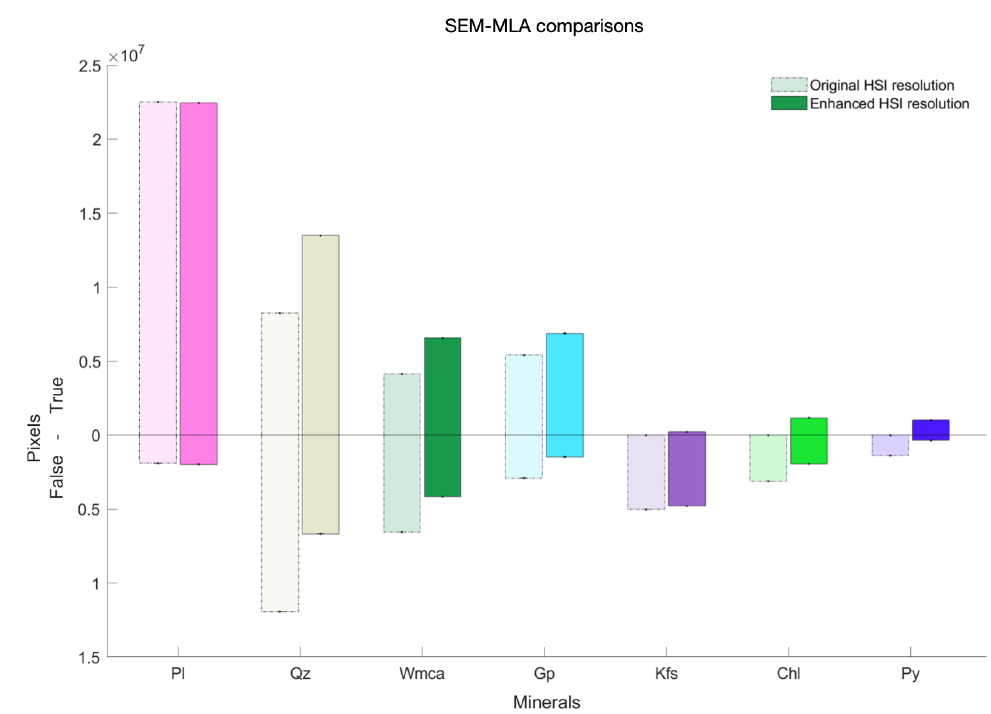
Figure 10. Comparison of mineral identification amongst original scanning electron microscopy- mineral liberation analysis (SEM-MLA), resampled SEM-MLA at the original resolution of the hyperspectral (HSI) data (dashed lines, transparent bars), and the resampled map at the enhanced resolution (continuous lines, opaque bars). (Pl—plagioclase, Qz—quartz, Wmca—white mica, Gp— gypsum, Kfs—K-feldspar, Chl—chlorite, and